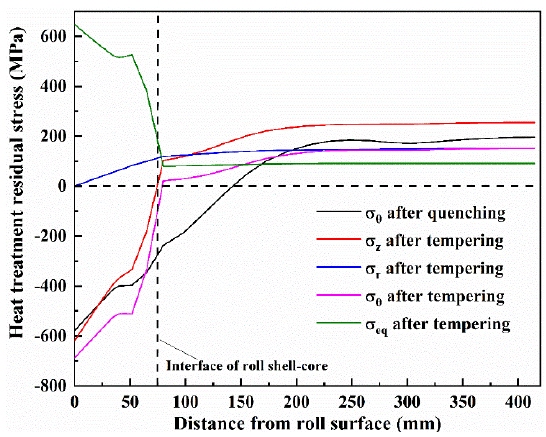
Figure 9. Distribution of the heat treatment residual stress in z, r and θ direction after the tempering process.